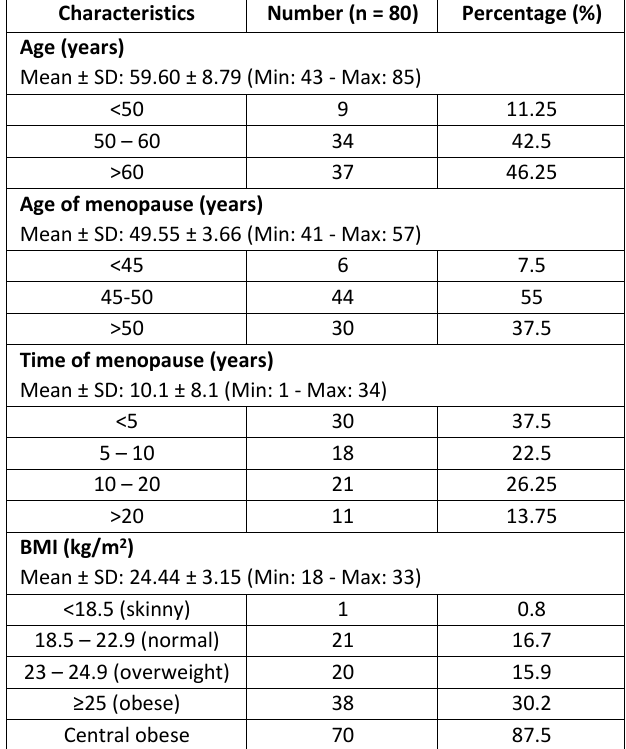
Table 1. Characteristics of menopausal women